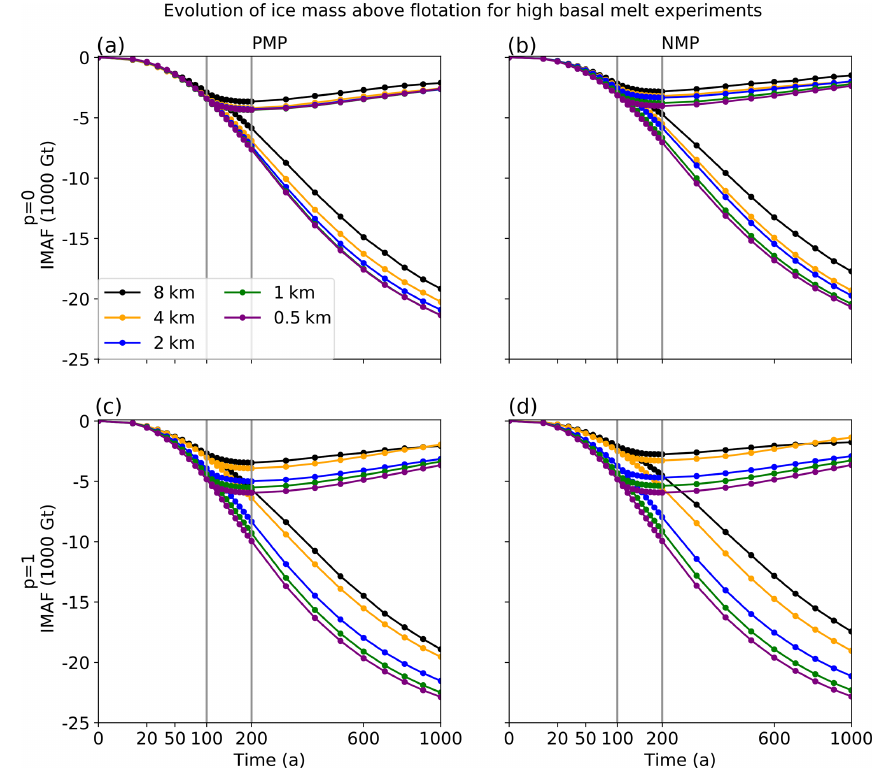
Figure 12. Evolution of IMAF relative to steady state for the full set of high-melt experiments. The layout is the same as in Fig.